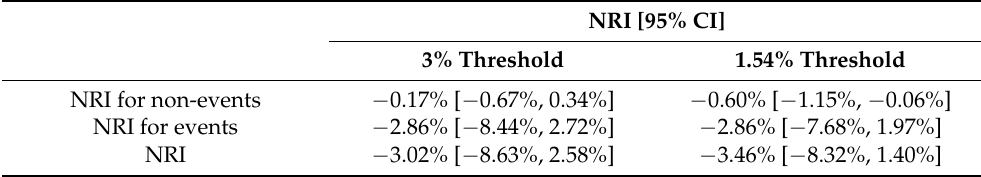
Table 4. Reclassification analysis for FRAX compared to the age and sex model, calculated with the available